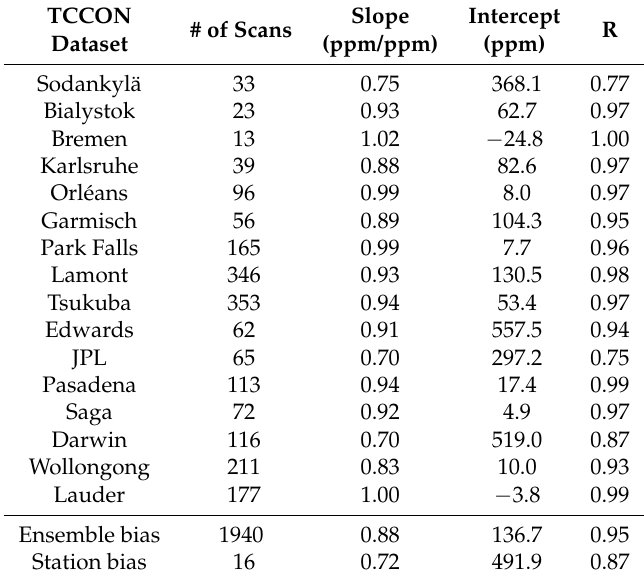
Table 3. Linear regression parameters (slope and intercept) and correlation coefficient (R) for TANSO-FTS scans acquired over land within ± 1 ◦ in latitude and in longitude of the TCCON sites and the average of TCCON measurements within ± 30min of the corresponding GOSAT overpasses. TCCON Slope Intercept # of Scans R